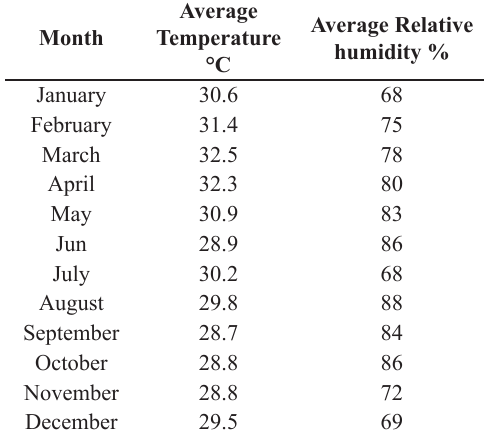
Source: National Service of Territorial Studies of El Salvador